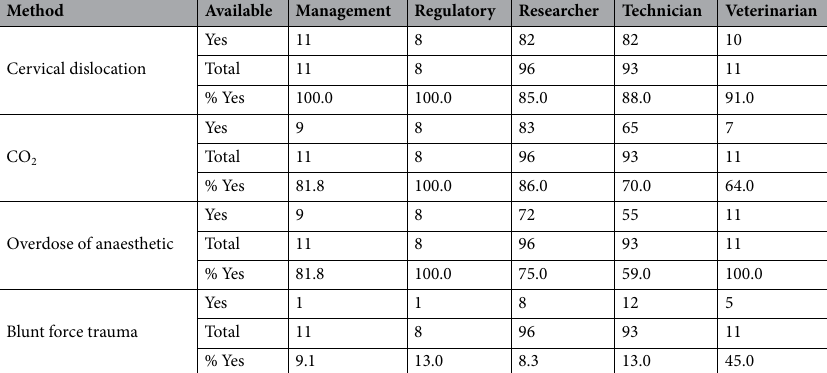
Table 1. Availability of Schedule 1 methods and use according to job